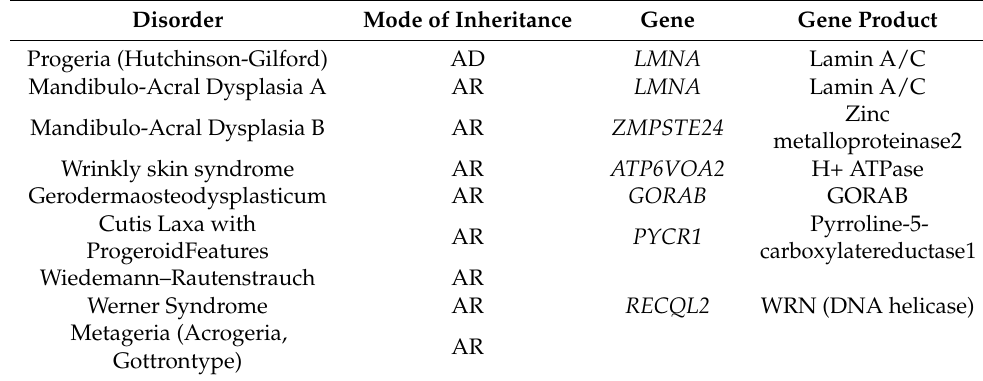
Table 11. Comparison Nosology OMIM vs. International Nosology